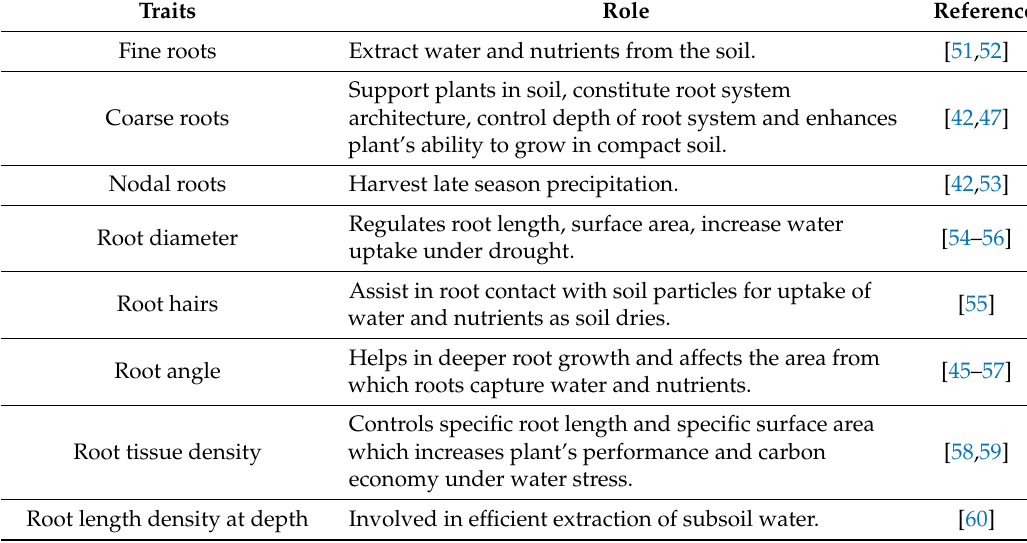
Table 1. Root traits and their role for improving crop productivity under